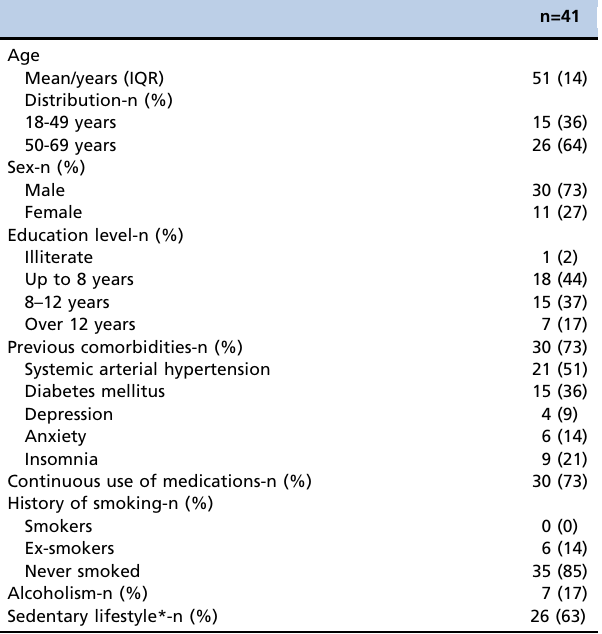
Table 1 - Patients profile.